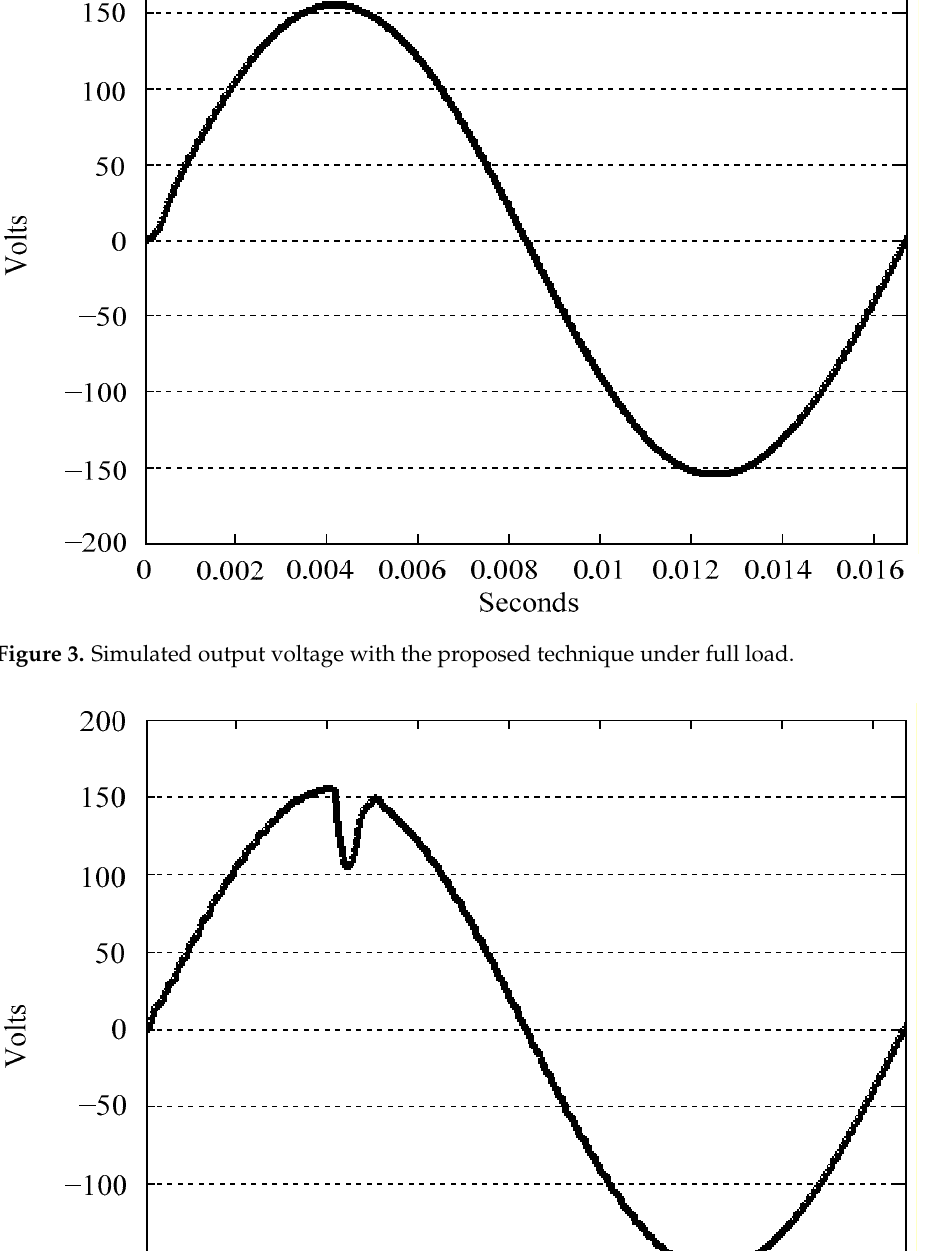
Figure 2. Simulated output voltage with the conventional SMC under full load.